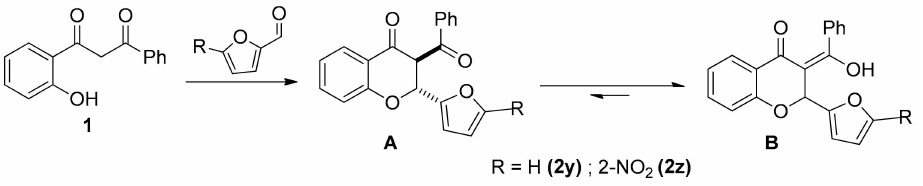
Scheme 2. Equilibrium for keto–enol